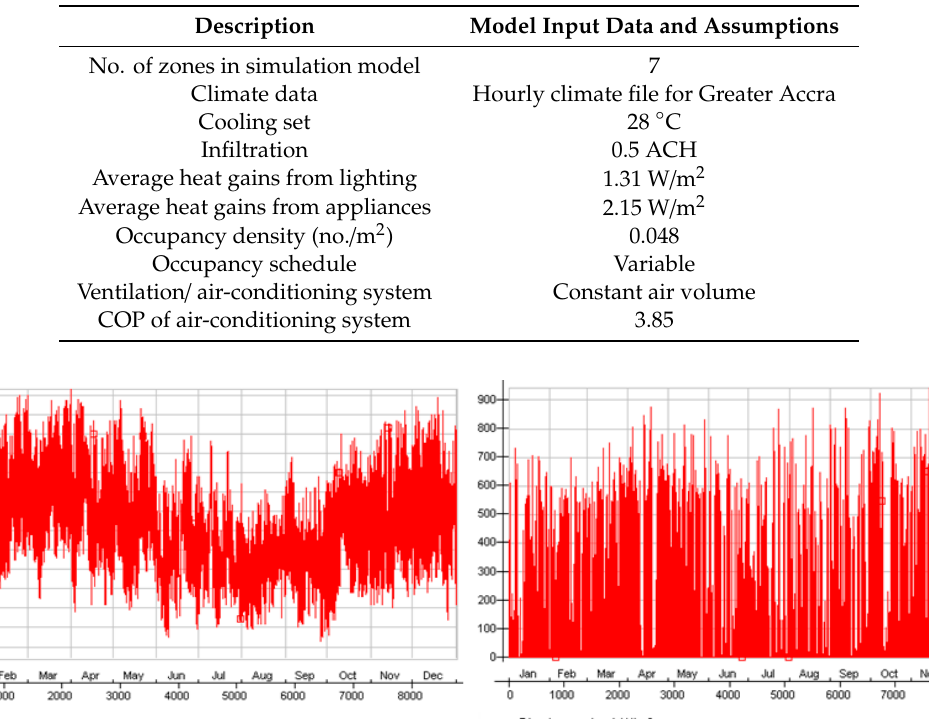
Table 3. Key input data for the energy balance and indoor-environment simulations.